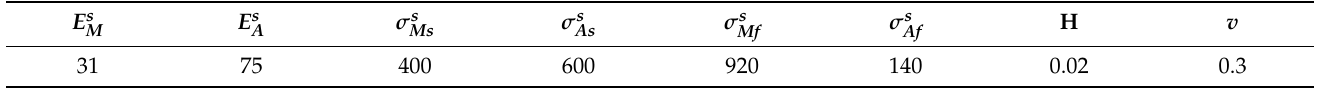
Table 1. Mechanical parameters of solid